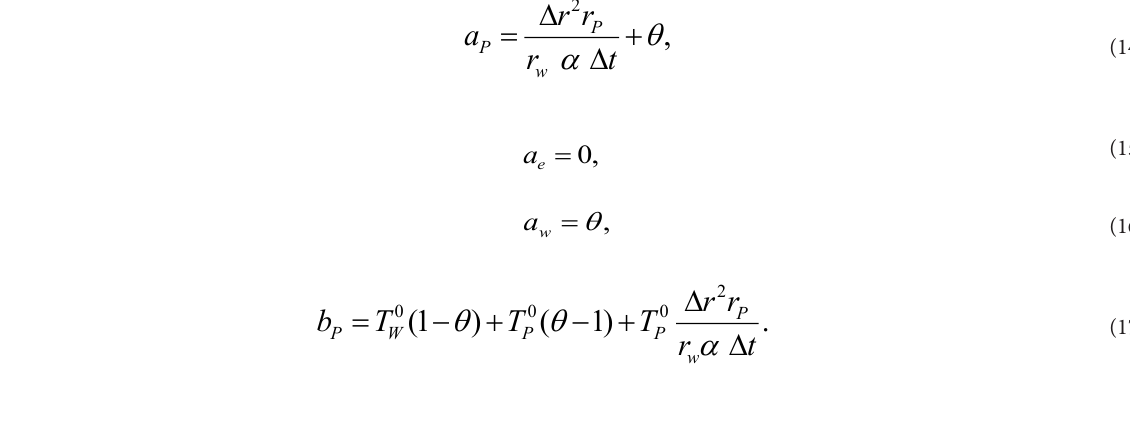
Finally, the approximation implemented to obtain the coefficients and the source term of the last volume, N , was the Upstream Differencing Scheme (UDS) (Maliska 2004; Versteeg and Malalasekera 1995). The coefficients and source term of the last volume are defined as (Eqs. 14 to